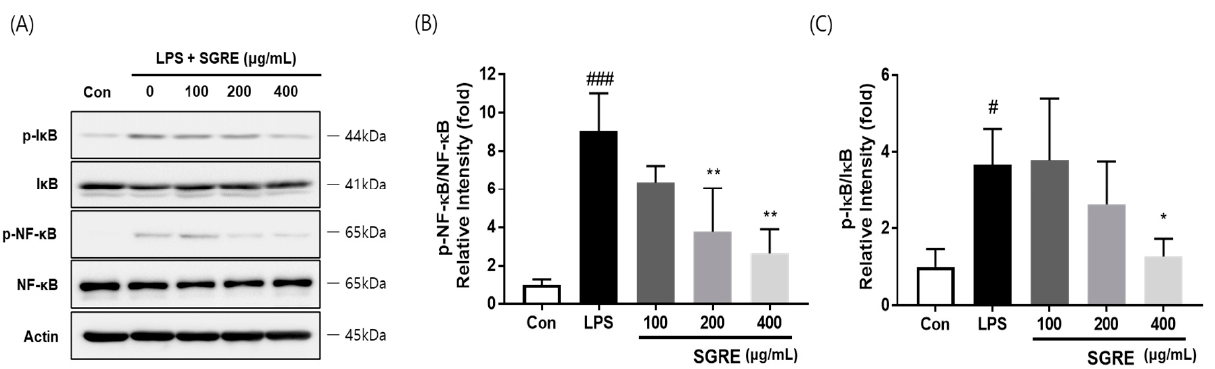
Figure 5. Effect of SGRE on the degradation or phosphorylation of proteins p65 and I κ B in LPS- induced RAW264.7 macrophages. ( A ) Representative Western blotting images of phosphorylated and total p65 and I κ B. ( B , C ) Quantification of the fold-change of phosphorylated p65 ( B ) and I κ B ( C ). # p < 0.05; ### p < 0.001 vs. control cells. * p < 0.05; ** p < 0.01 vs. LPS-treated cells.